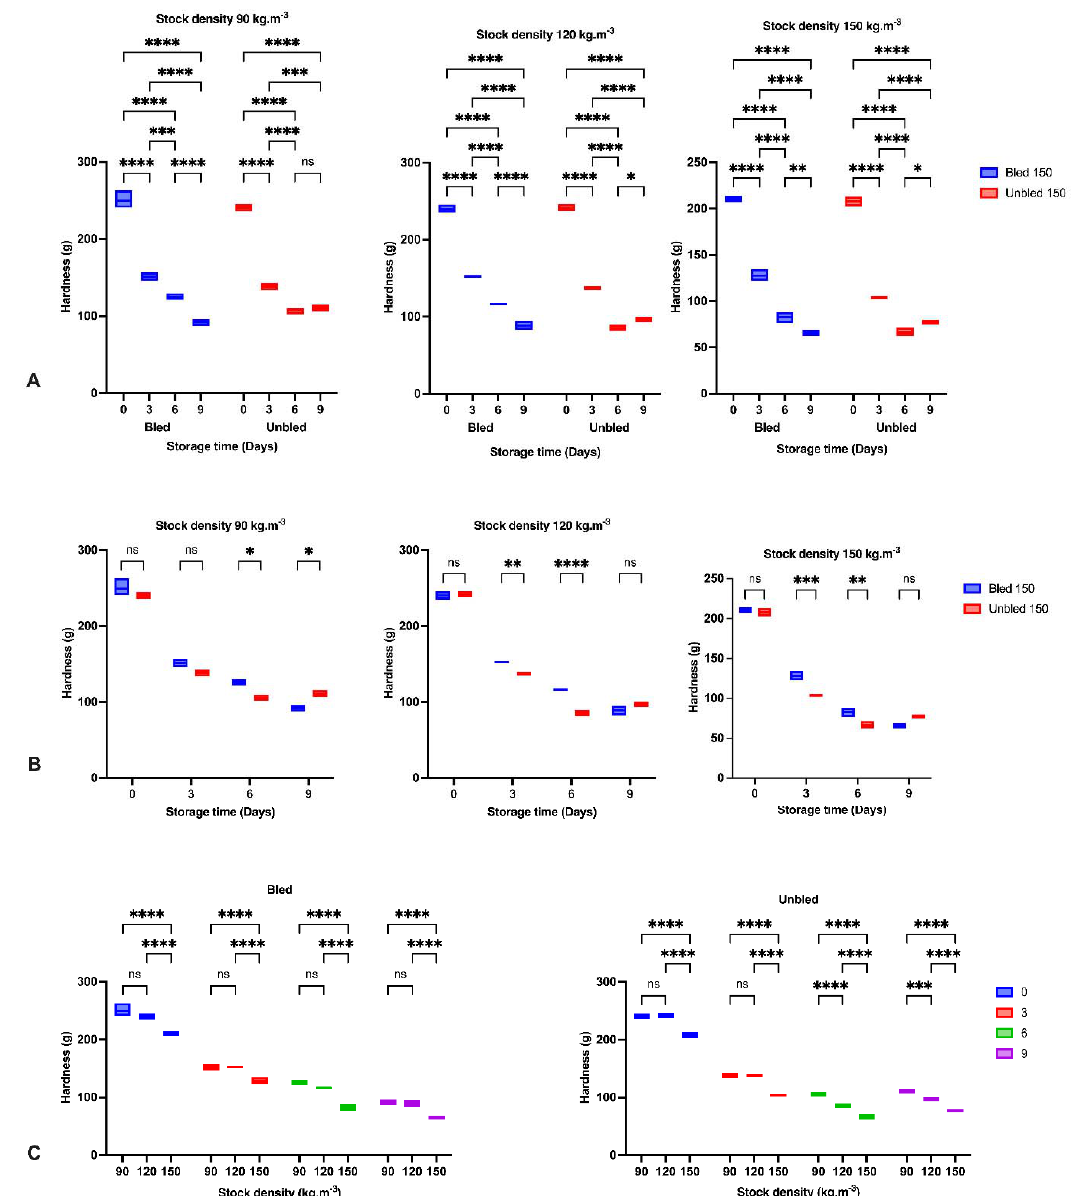
Figure 2. Hardness: ( A ) During the storage time (0, 3, 6 and 9 Days) in bled and un ‐ bled groups at different stock densities (90, 120 and 150 kg.m _3 ); ( B ) In bled and un ‐ bled groups at each storage time (0, 3, 6 and 9 Days) and at different stock densities (90, 120 and 150 kg.m _3 ); ( C ) In different stocking densities (90, 120 and 150 kg.m _3 ) during storage time (0, 3, 6 and 9 Days) in bled and un ‐ bled groups; ( p < 0.05, Tukey’s multiple comparisons test; ns: non ‐ significant; * p < 0.05; ** p < 0.01; *** p < 0.001; **** p < 0.0001). Box plots showing line at mean. Box plots showing the line at upper quartile, lower quartile and at the mean.